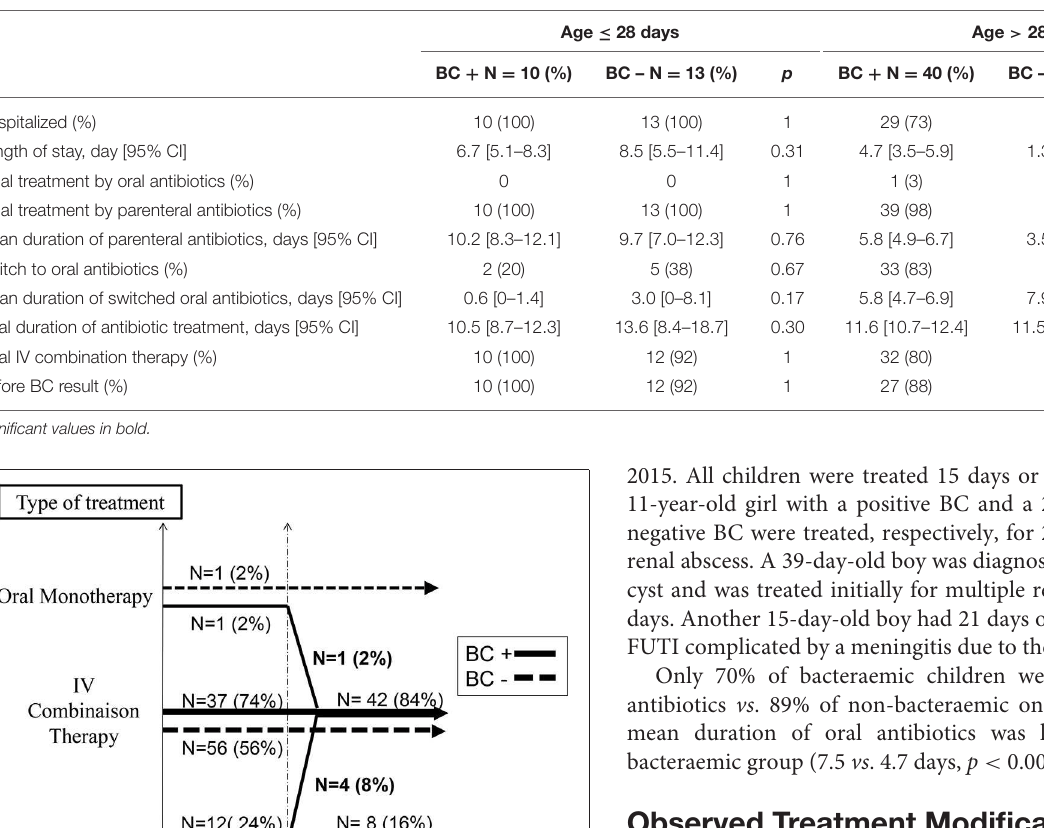
TABLE 2 | Comparaison of clinical management of patients with FUTI depending of their age.